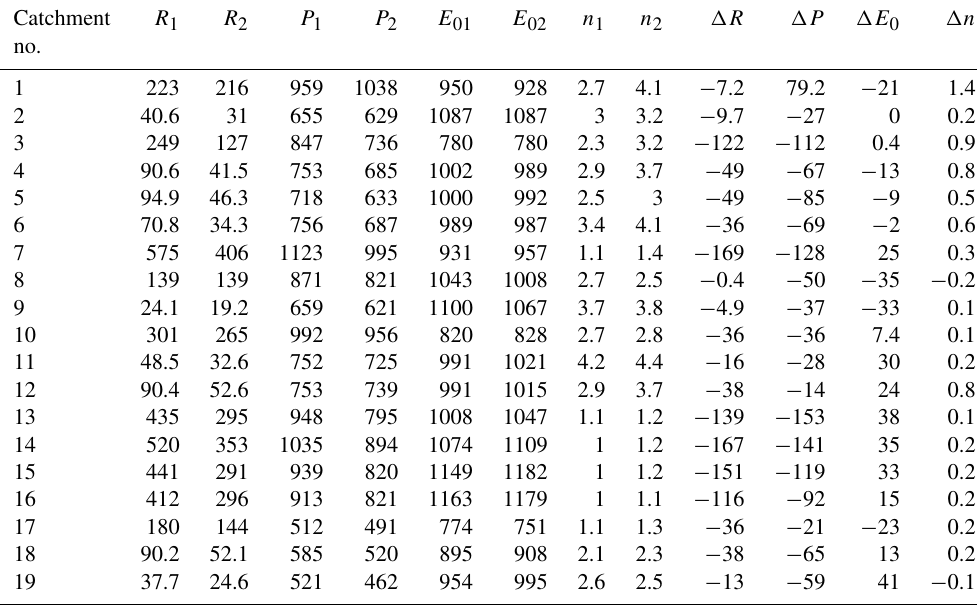
Table 2. Comparisons of R (mmyr − 1 ) , P (mmyr − 1 ) , E 0 (mmyr − 1 ), and n (dimensionless) between the reference and the evaluation periods ∗ .